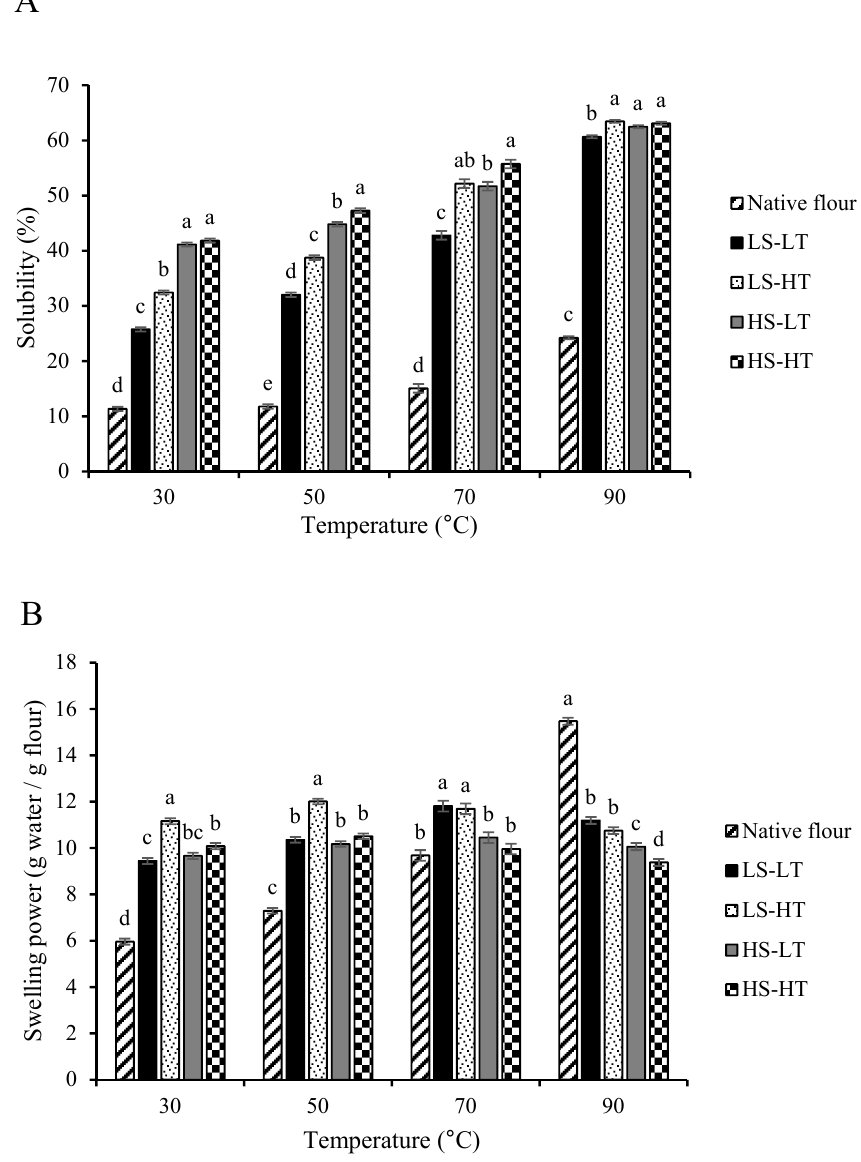
Figure 3. Solubility ( A ) and swelling power ( B ) of native and extruded breadfruit flours. Within each temperature, means without a common superscript differ ( P ≤ 0.05). Treatments include native breadfruit flour and four extruded breadfruit flours: LS-LT: SME = 74 kJ/kg, melt temperature = 83 °C; LS-HT: SME = 74 kJ/kg, melt temperature = 105 °C; HS-LT: SME = 145 kJ/kg, melt temperature = 100 °C; HS-HT: SME = 145 kJ/kg, melt temperature = 126 °C.